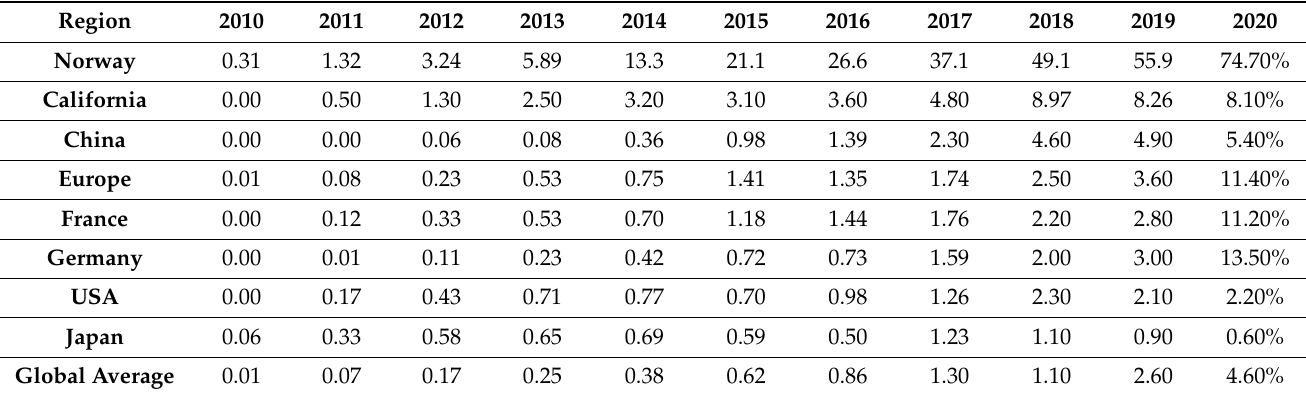
Table 2. Market penetration of PEVs by region 2010–2020